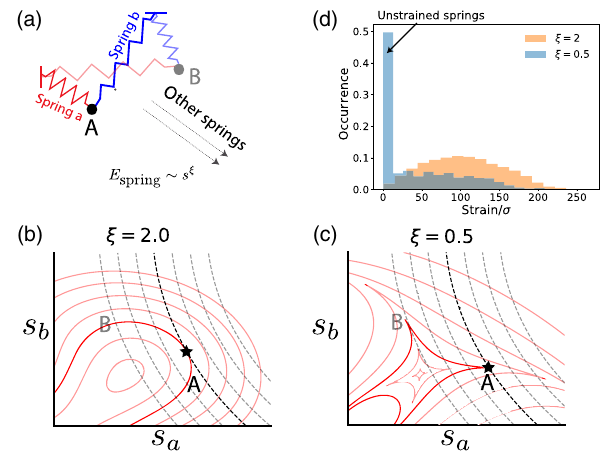
FIG. 5. Nonlinear springs act like a Bayesian prior that ensures sparse strain distributions. (a) Red spring a stabilizes the ball position at point A, while the blue spring b stabilizes the ball at position B. (b) The energy of the red and blue springs is represented by red contours, that of all other springs by black contours. The system ’ s energy is minimized at a point where red and black contours are tangent to each other. If ξ > 1 , the minimum is at a generic point with no special features. (c) If ξ ≤ 1 , the minimum is very likely to be at a red cusp, corresponding to a configuration in which either the red or blue springs is unstrained. (d) Typical stable states of a large N ¼ 100 network have many unstrained springs if and only if ξ ≤ 1 .